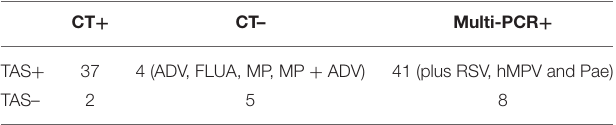
TABLE 3 | TAS positive pathogens identification based on CT or Multi-PCR results.